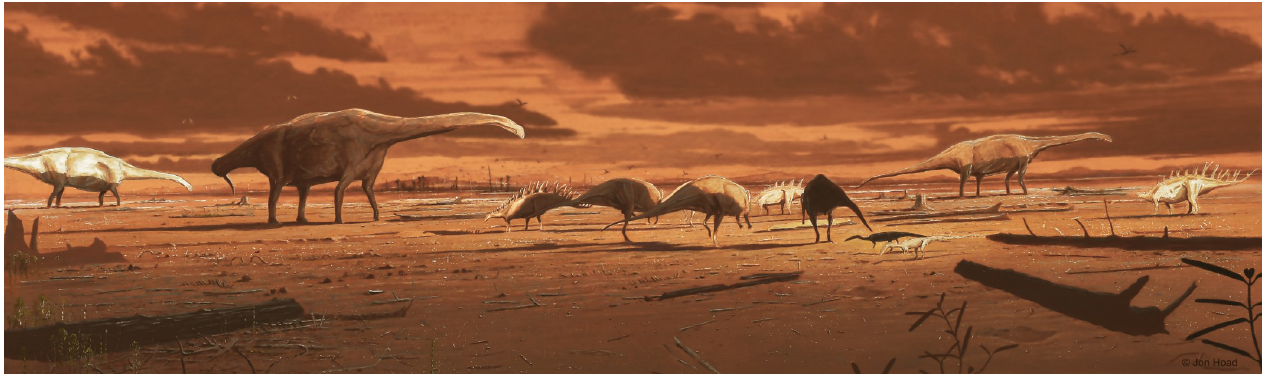
Fig 24. Reconstruction of Middle Jurassic ecosystem on the Isle of Skye, Scotland. A snapshot of what the dynamic coastal environment of Skye may have looked like during the Middle Jurassic which bipedal ornithopods, theropods of various sizes, and stegosaurs in the foreground and middle on subaerially- exposed mudflats. In the distance, large sauropods wade in shallow lagoons. Paleoartist: Jon Hoad.